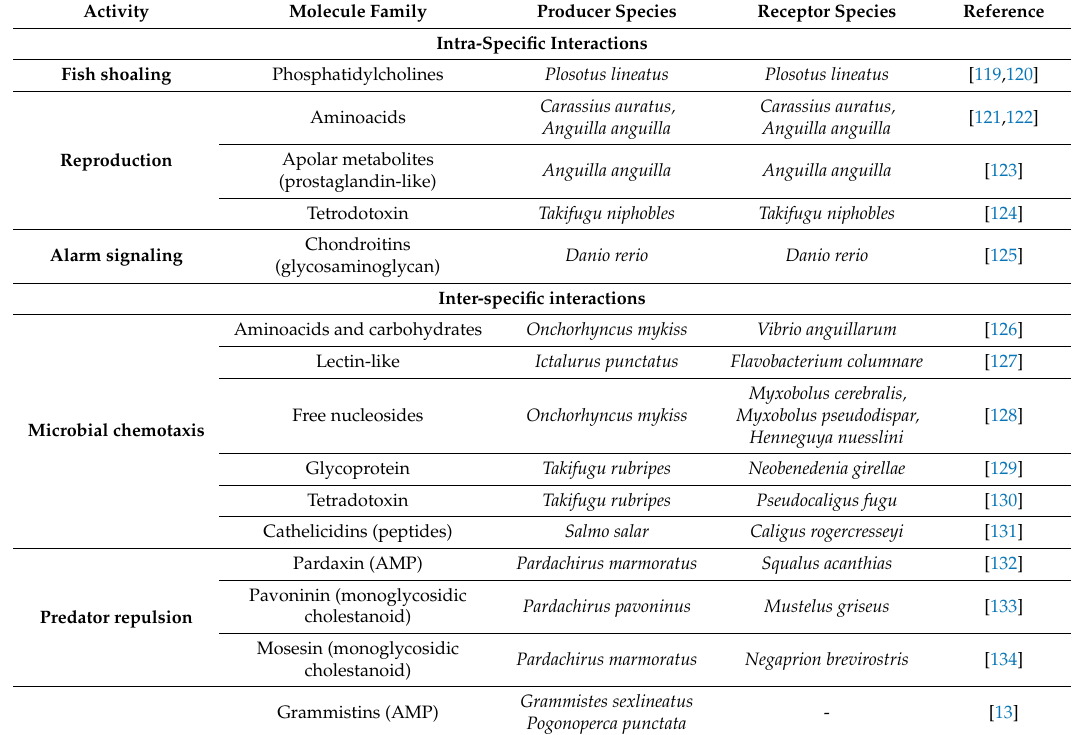
Table 2. Fish mucus molecules involved in ecological